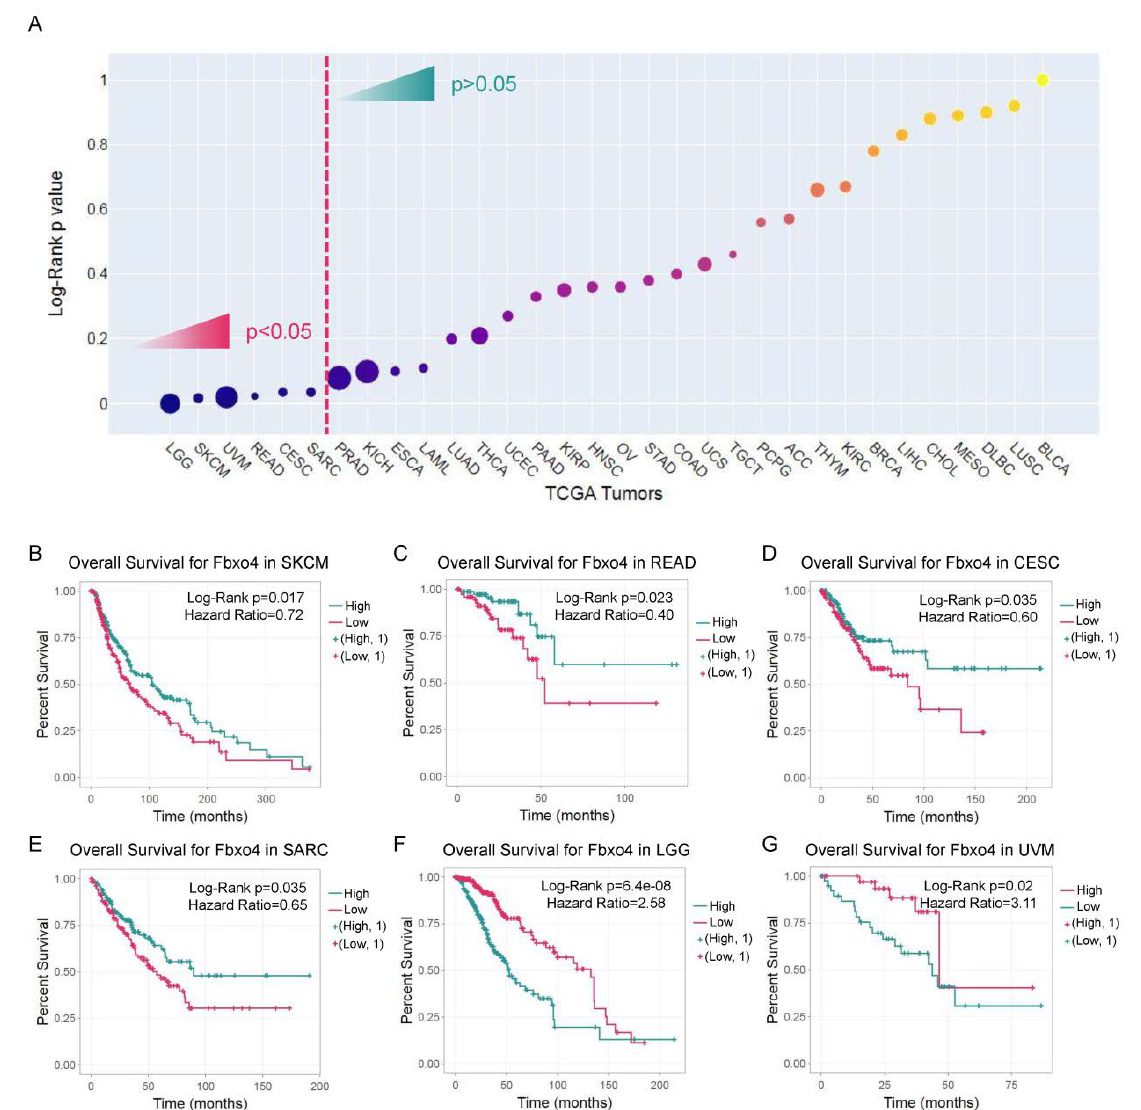
Figure 6. The prognostic importance of Fbxo4 in tumors from the human TCGA database. This analysis is processed by the ENCORI online tool (https://starbase.sysu.edu.cn (accessed on 12 April 2022)). ( A ) The summarization of Log-Rank p values of different TCGA tumors; y-axis indicates the p values and the circle size indicates the hazard ratio for each tumor. ( B – G ) Survival analysis based on Fbxo4 expression in patients with SKCM, READ, CESC, SARC, LGG and UVM. The cut-off of Log-Rank p value is setup at 0.05, and Hazard Ratio is shown in the figures.